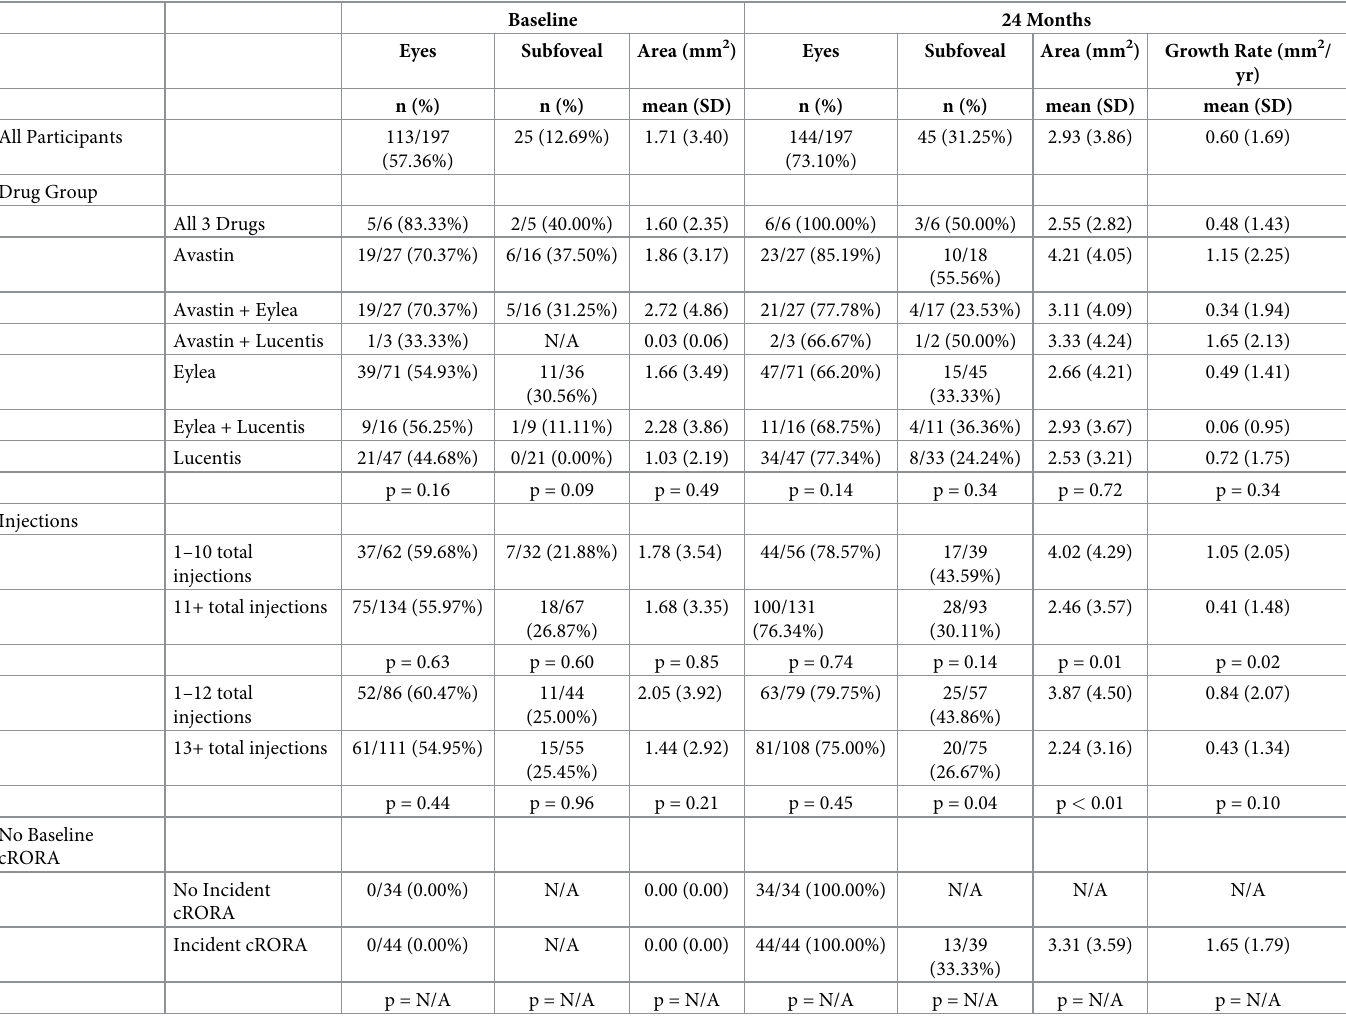
Table 3. Presence, location, area, and growth of complete RPE and outer retinal